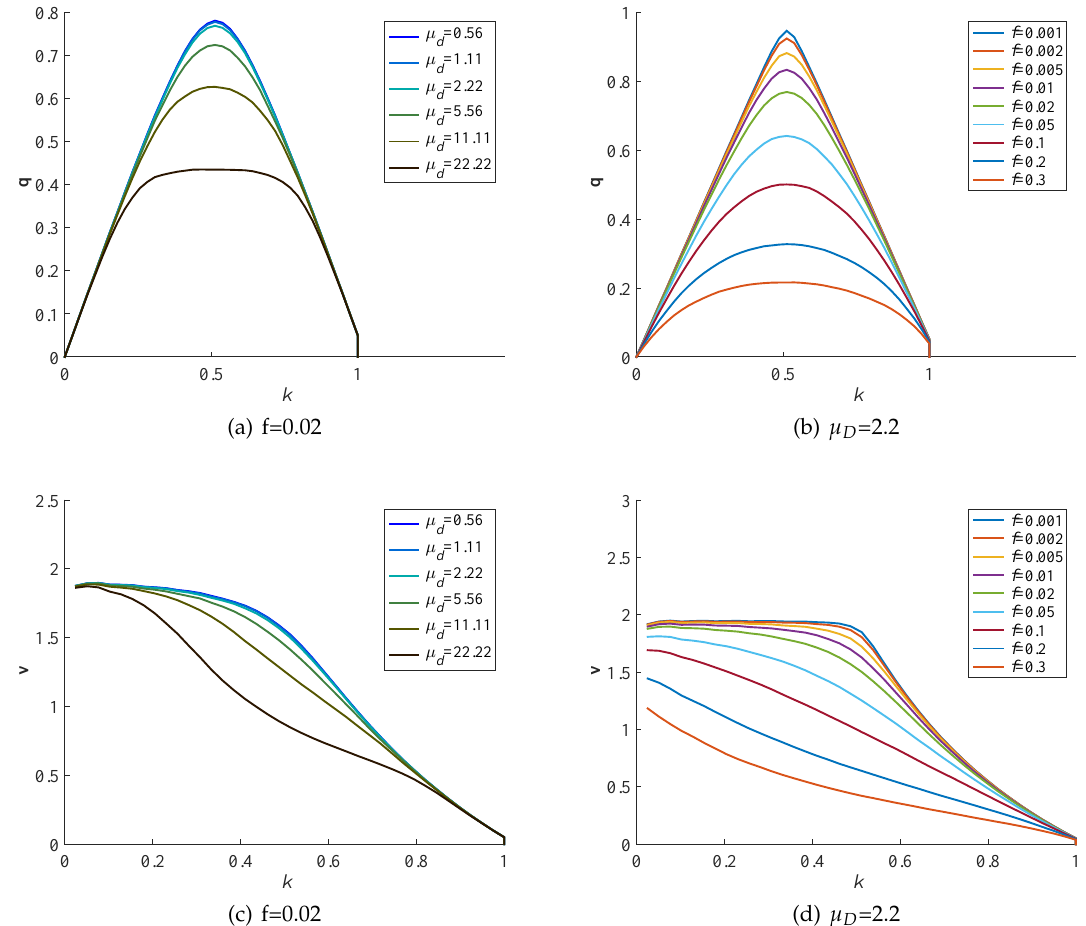
Figure 2. Flow and speed for combination of crosswalk distance and pedestrian flow; for all figures, σ D =